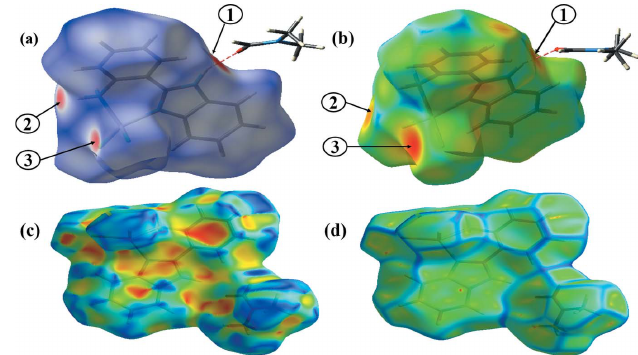
Figure 2 A packing view approximately along [101] of the title complex. Hydrogen atoms are omitted for clarity.